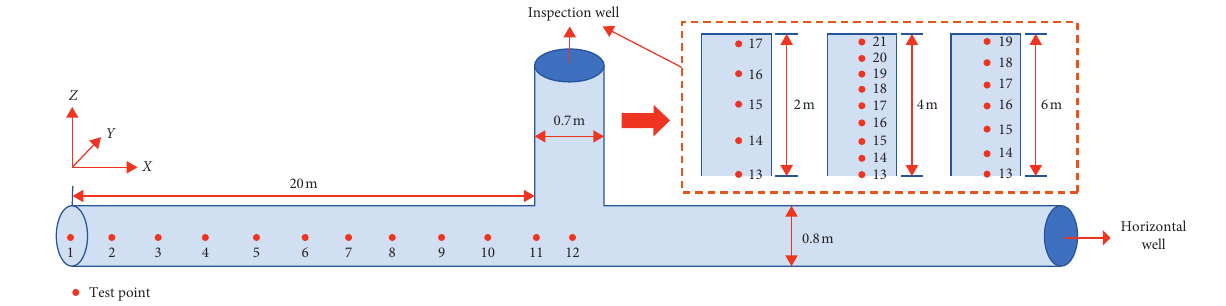
Figure 3: Model schematic diagram. Table 1: Simulation